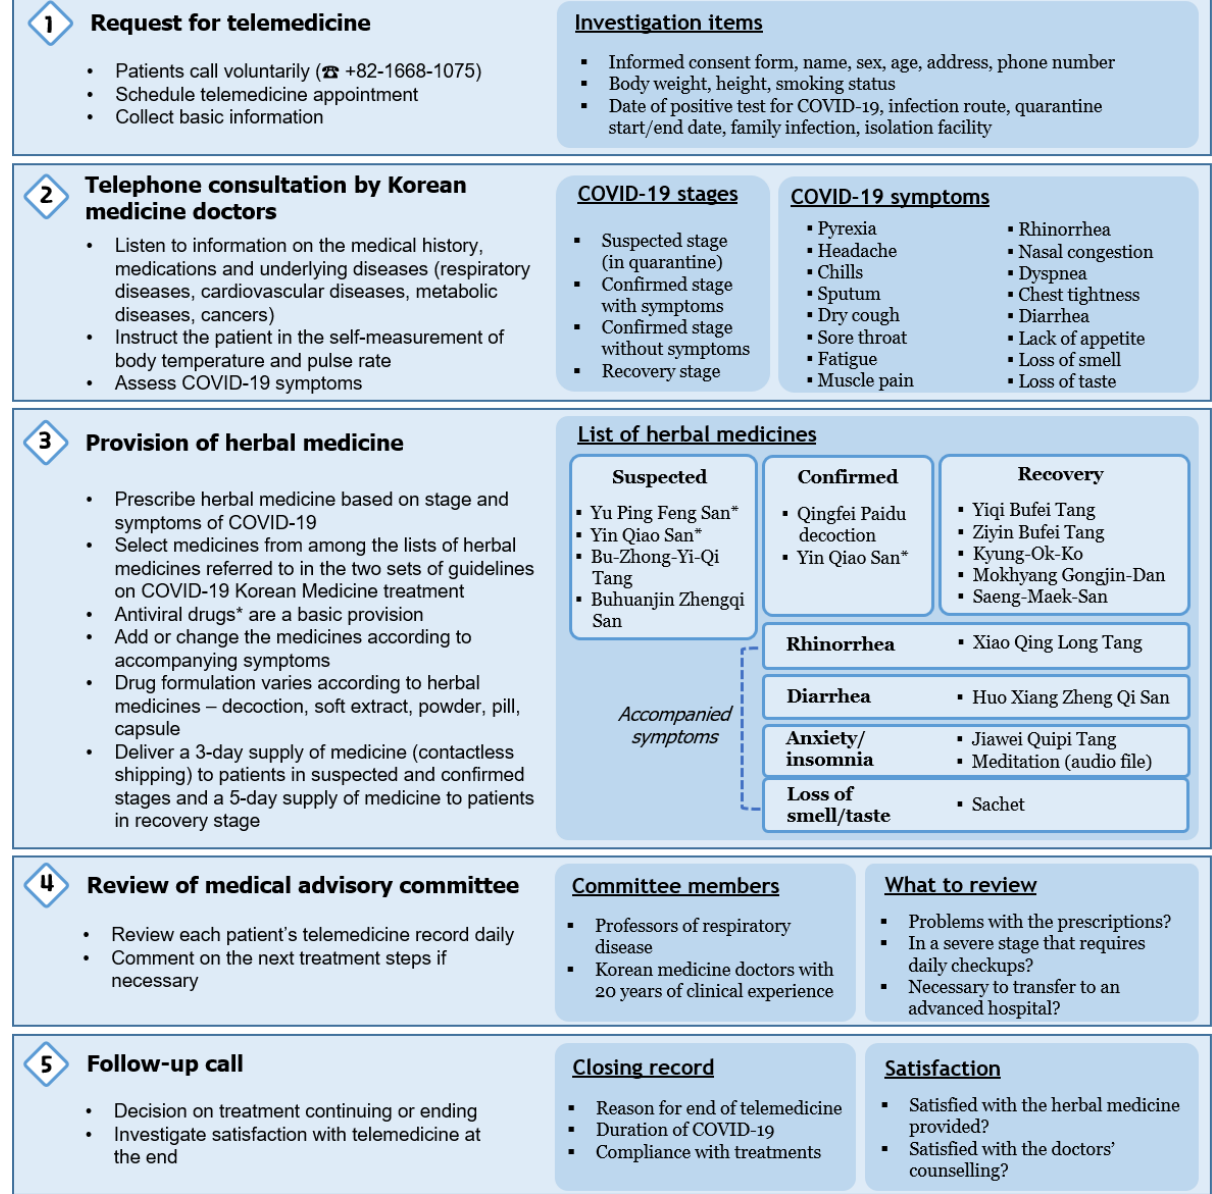
KM Telemedicine Center